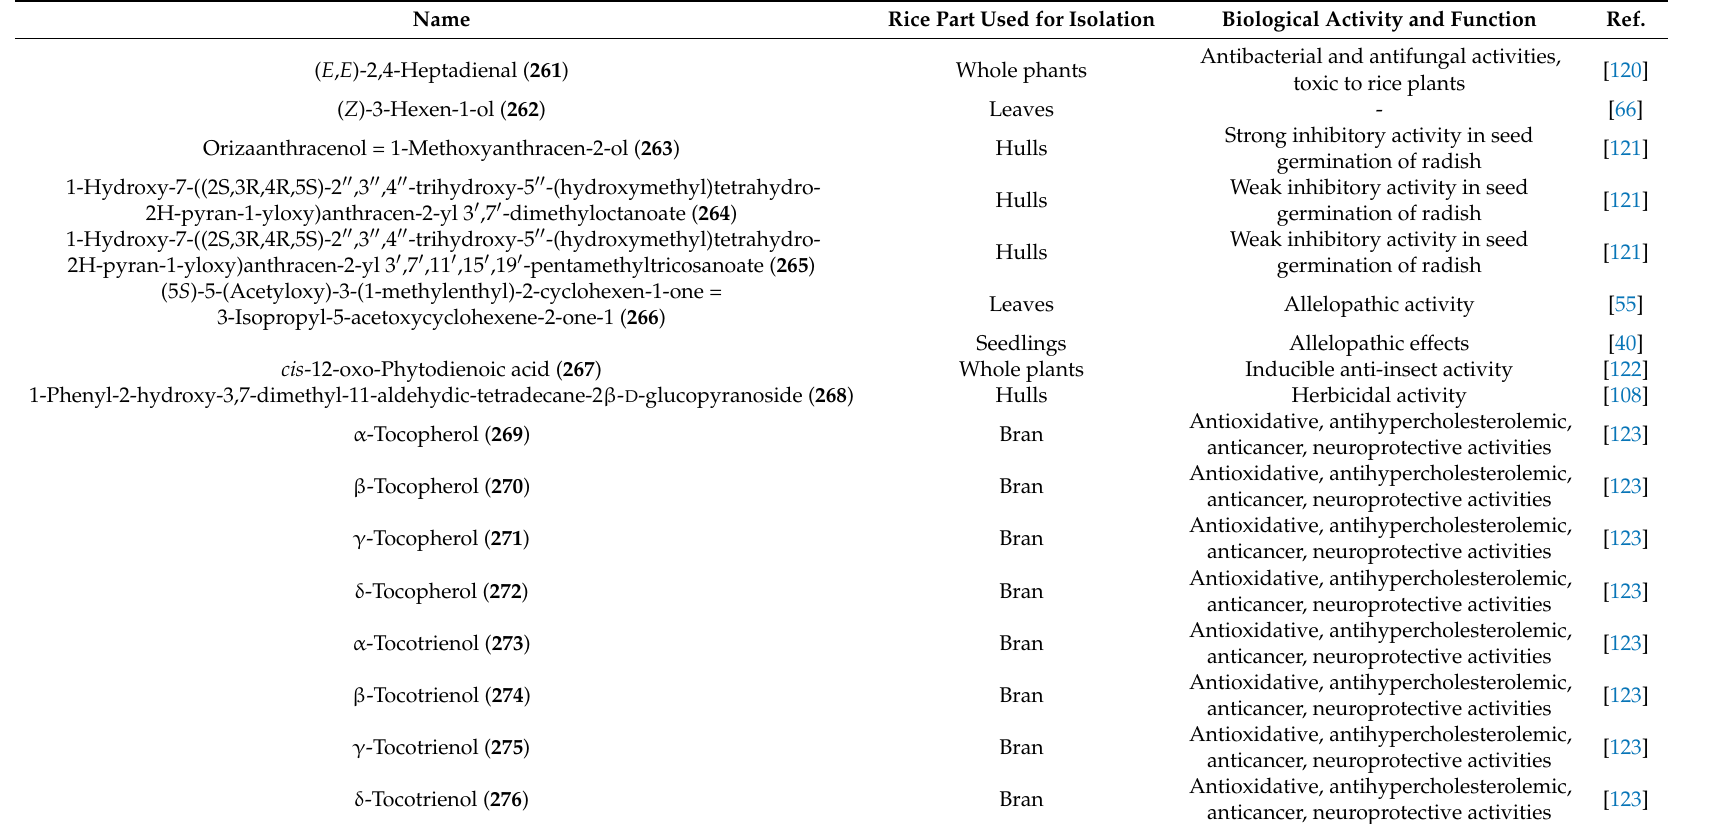
Table 9. Other metabolites and their biological